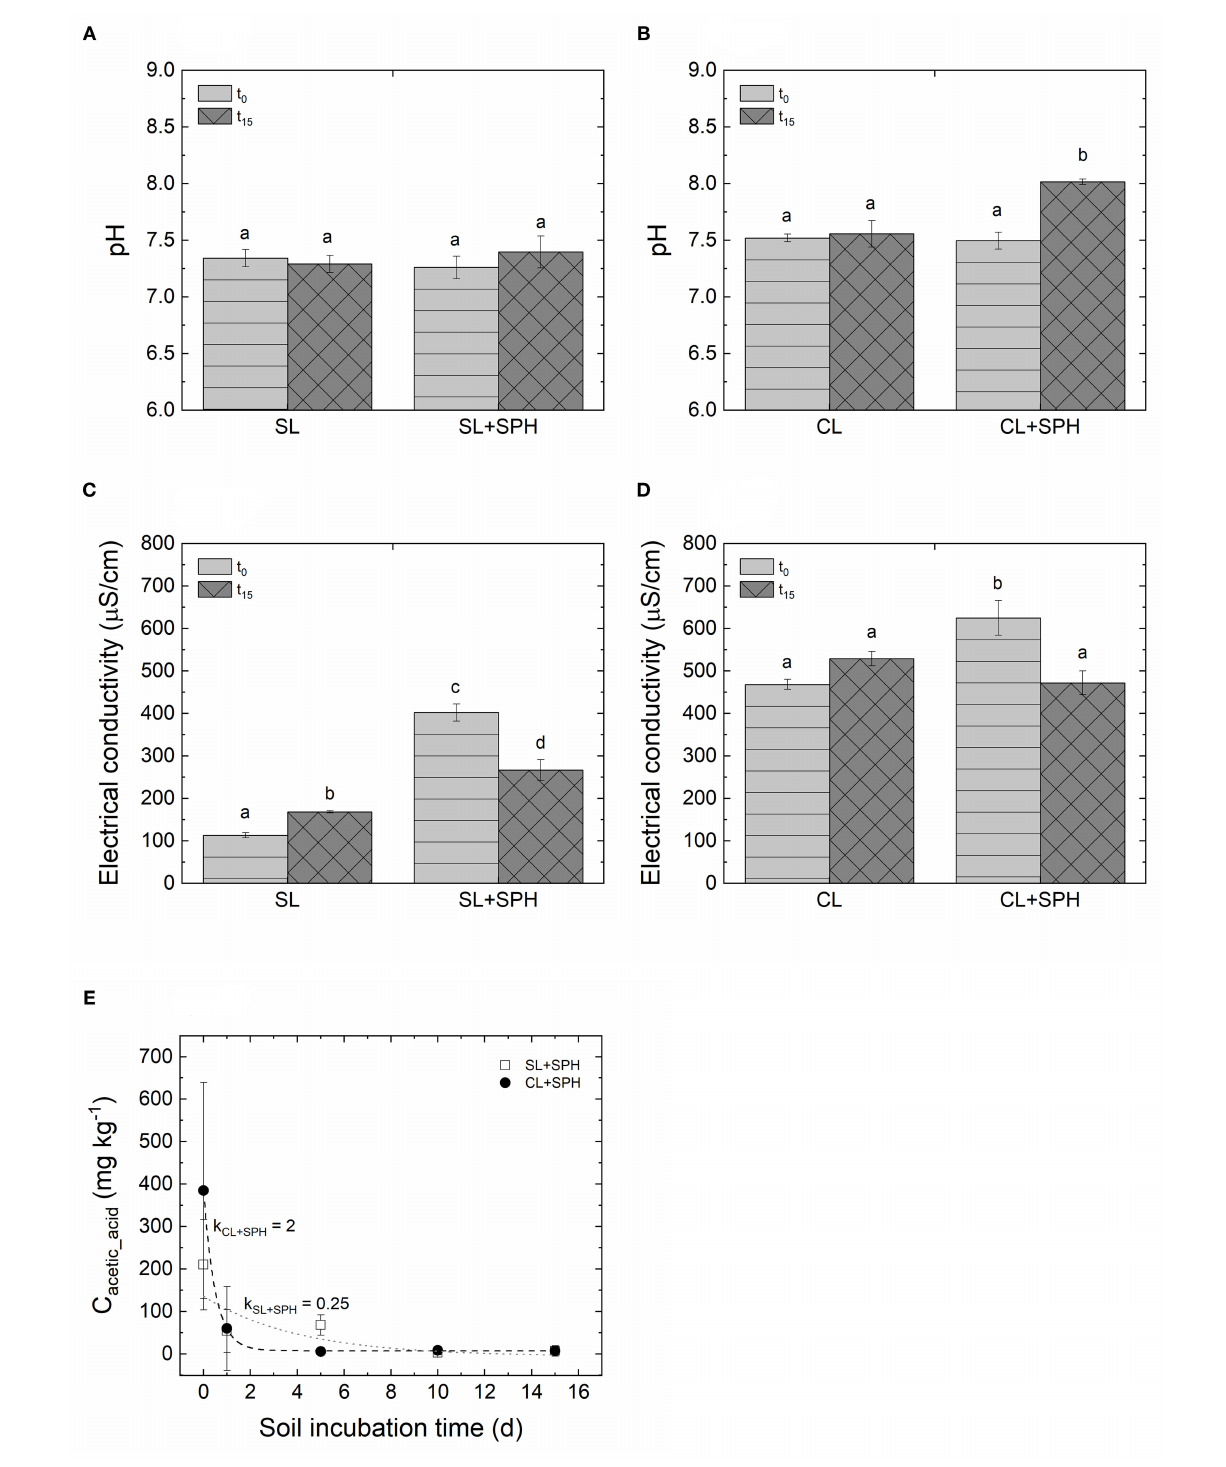
Frontiers in Sustainable Food Systems |